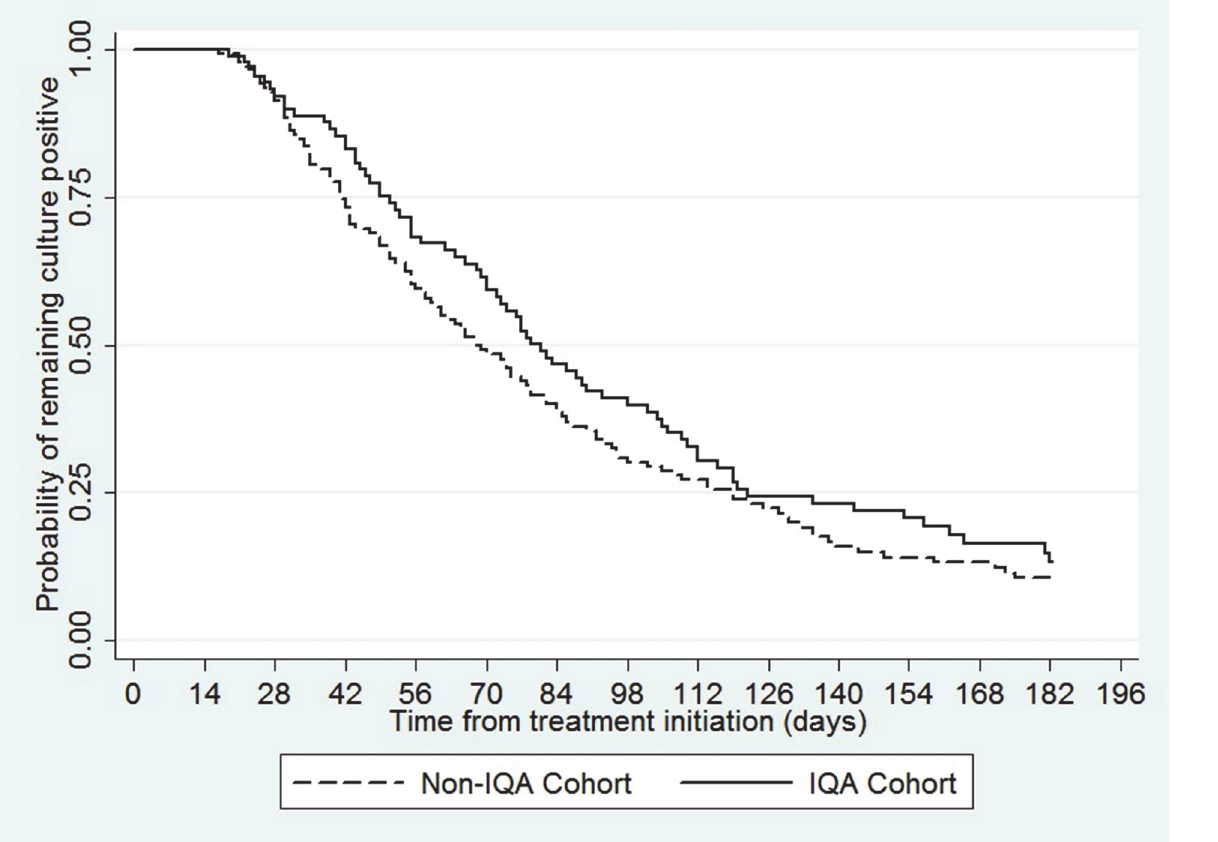
Fig 1. Kaplan-Meier curve showing time to culture conversion by cohort (n =